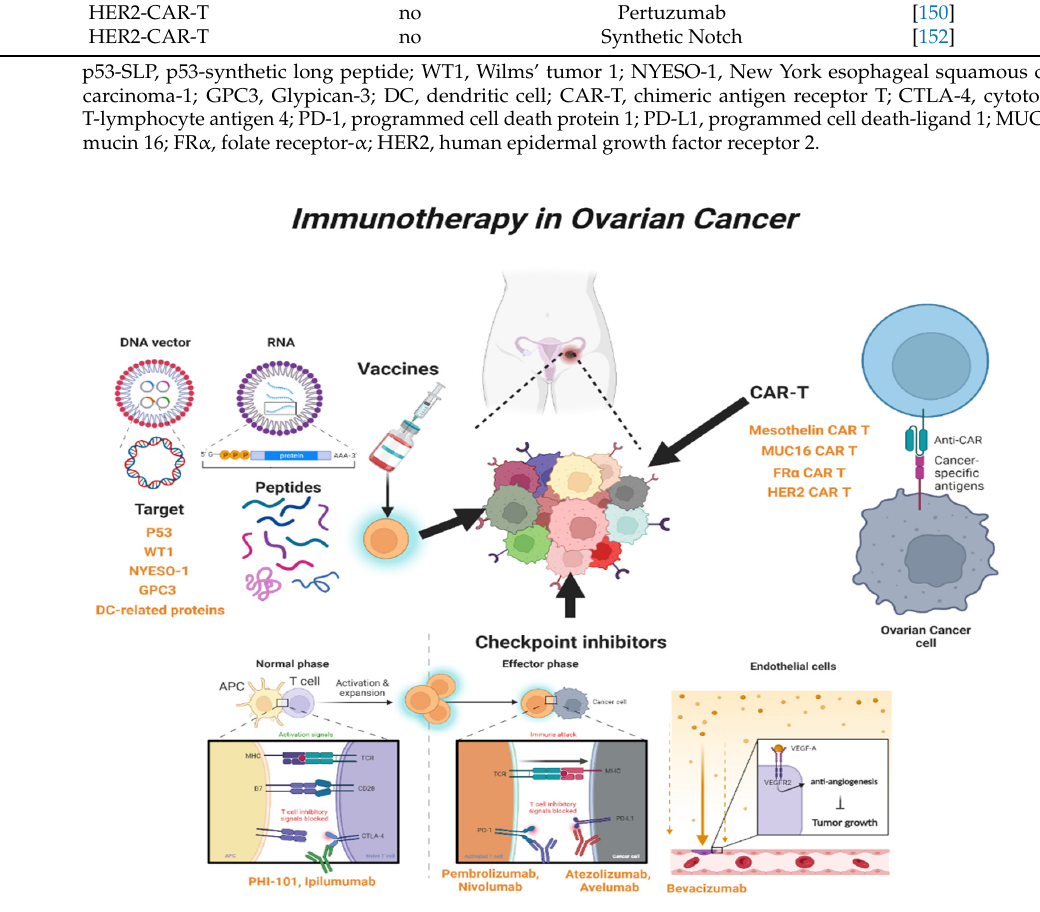
Figure 2. Overview of immunotherapy in OC. Schematic showing the types and mechanisms of T-cell-mediated immunotherapy currently used in clinical practice. WT1, Wilms’ tumor 1; NYESO-1, New York esophageal squamous cell carcinoma-1; GPC3, Glypican-3; DC, Dendritic cell; CAR-T, Chimeric Antigen Receptor T; CTLA-4, Cytotoxic T-lymphocyte antigen 4; PD-1, Programed cell death protein 1; PD-L1, Programed cell death-ligand 1; MUC16, Mucin 16; FR α , Folate receptor- α ; HER2, human epidermal growth factor receptor 2.